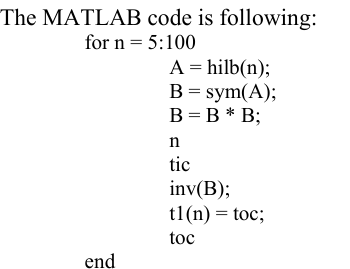
Figure 2. Vertical axis: calculation time (seconds) Horizontal axis: matrix size (N x